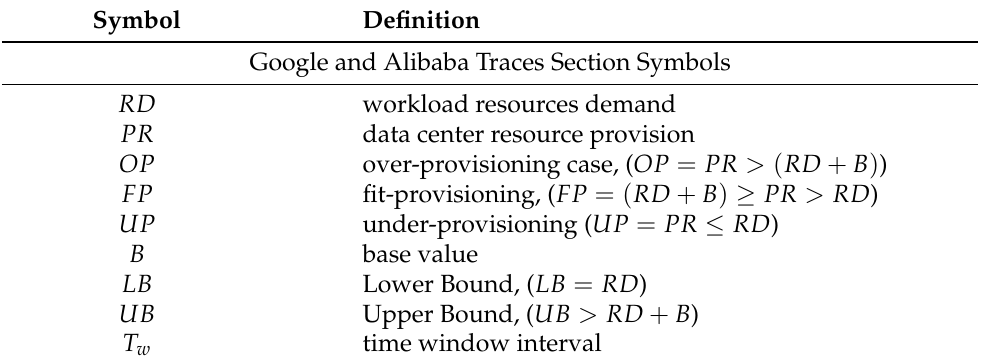
Table 1. Key Symbols Used in the Analysis and their Definitions.